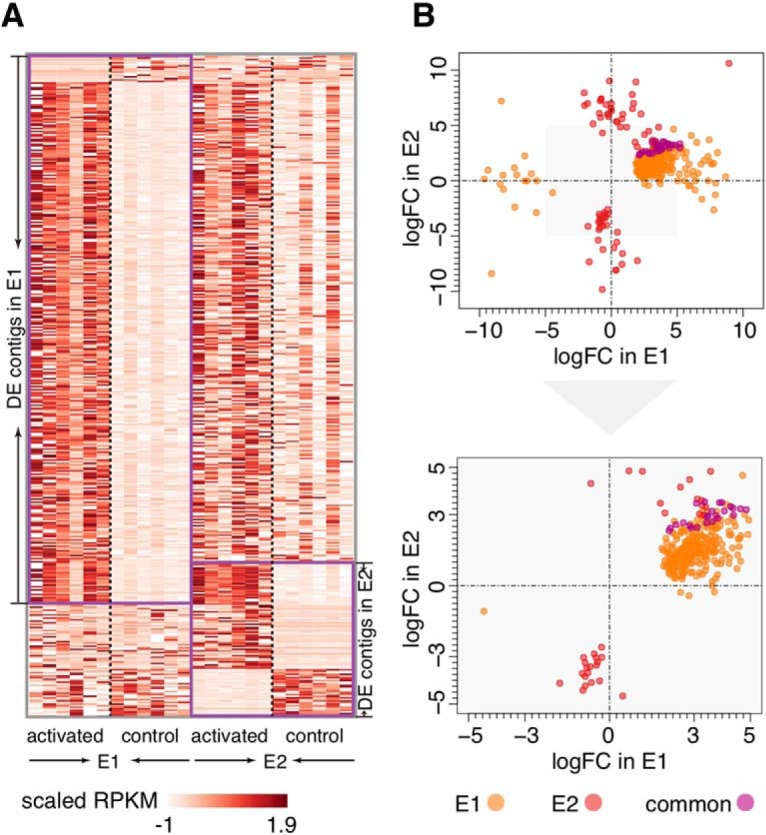
Differential expression after the neuronal stimulation. A, Heat map showing expression levels as standard-normalized RPKM values of 422 DE contigs classified as DE in at least one of the two experiments. Purple boundaries indicate contigs showing significant expression differences in each experiment. B, up, Scatter plot showing the amplitude and the direction of expression differences of the 422 DE contigs in E1 and E2 as log2-transformed fold changes (logFC). The colors indicate significant expression differences in one or both experiments. Down, Zoomed in area of the upper plot shaded in gray.